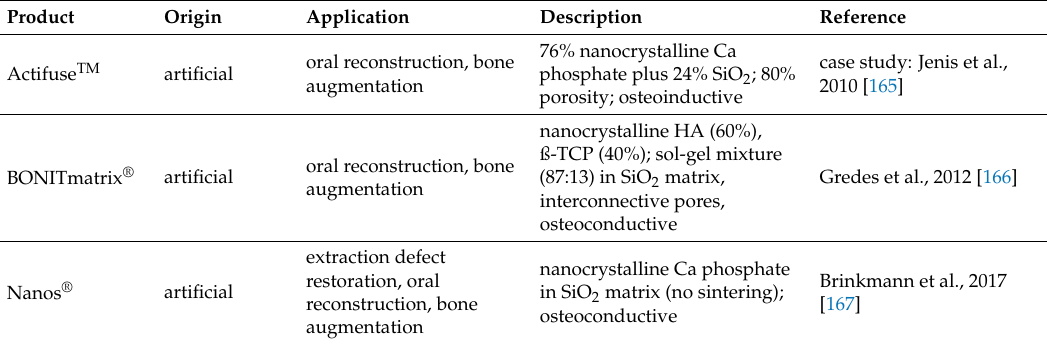
Table 2. Commercial scaffolds, their composition, and application